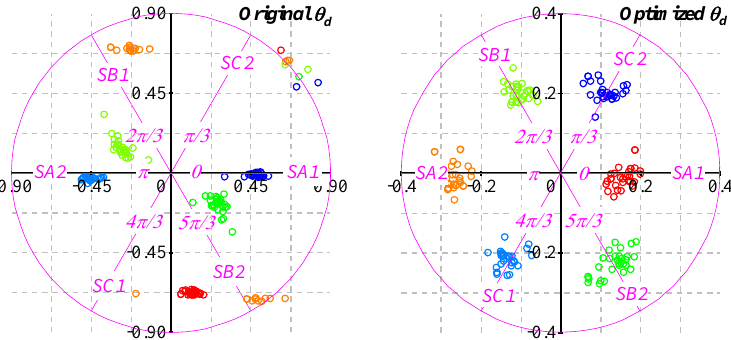
Figure 15. Fault location data distribution with original and optimized θ d .